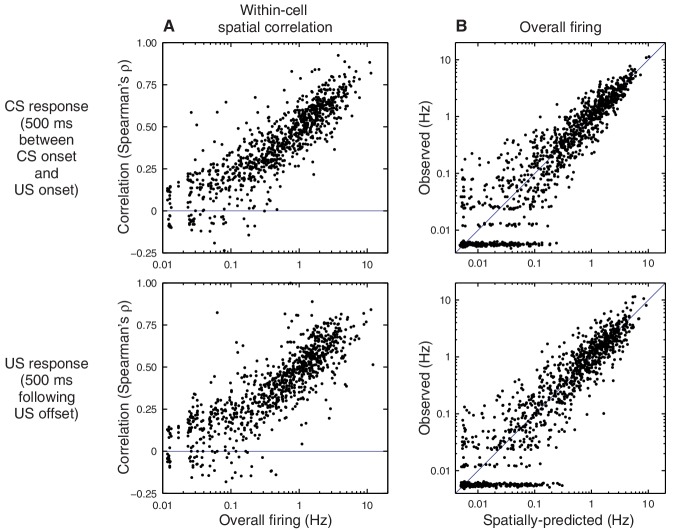
Spatial tuning predicts CS- and US-evoked responses on a single-cell basis.This figure shows additional cell-by-cell analyses. Each dot represents a single recorded cell. The top row analyzes the CS response (firing in the 500 ms window between the CS onset and the US onset), and the bottom row analyzes the US response (firing in the 500 ms following the US offset). (A) Within-cell correlation (Spearman’s ρ), across trials, between spatial tuning and stimulus-evoked firing. A correlation of 1 indicates that a cell exhibits a strictly monotonic relationship between place field intensity and observed firing. Note that all cells exhibit a positive correlation except those that fired very few spikes overall; such cells have many trials with zero observed spikes, and these ties reduce the measured correlation. The top plot is a duplicate of Figure 2F. (B) Predicted vs. observed stimulus-evoked firing rate for each cell (averaged over trials). Note that all cells lie close to the diagonal, and there are no outliers to suggest a subpopulation of cells that deviates from the spatially-predicted rates. Values less than 0.01 are not shown to scale.